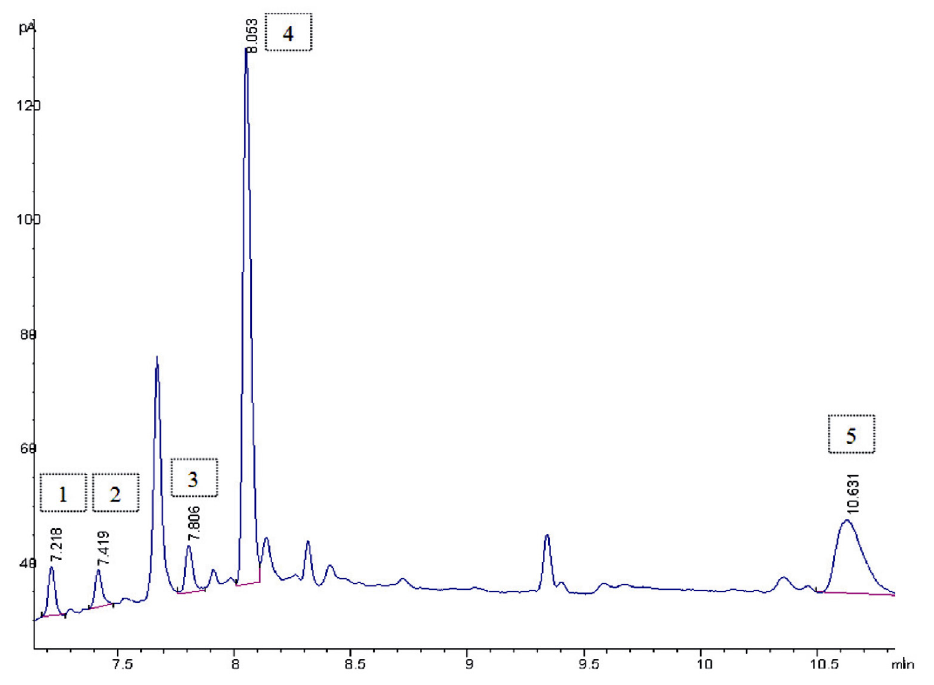
Figure 1. Gas chromatogram of camelina oil sample. Identifiers are the same as in Table 1.